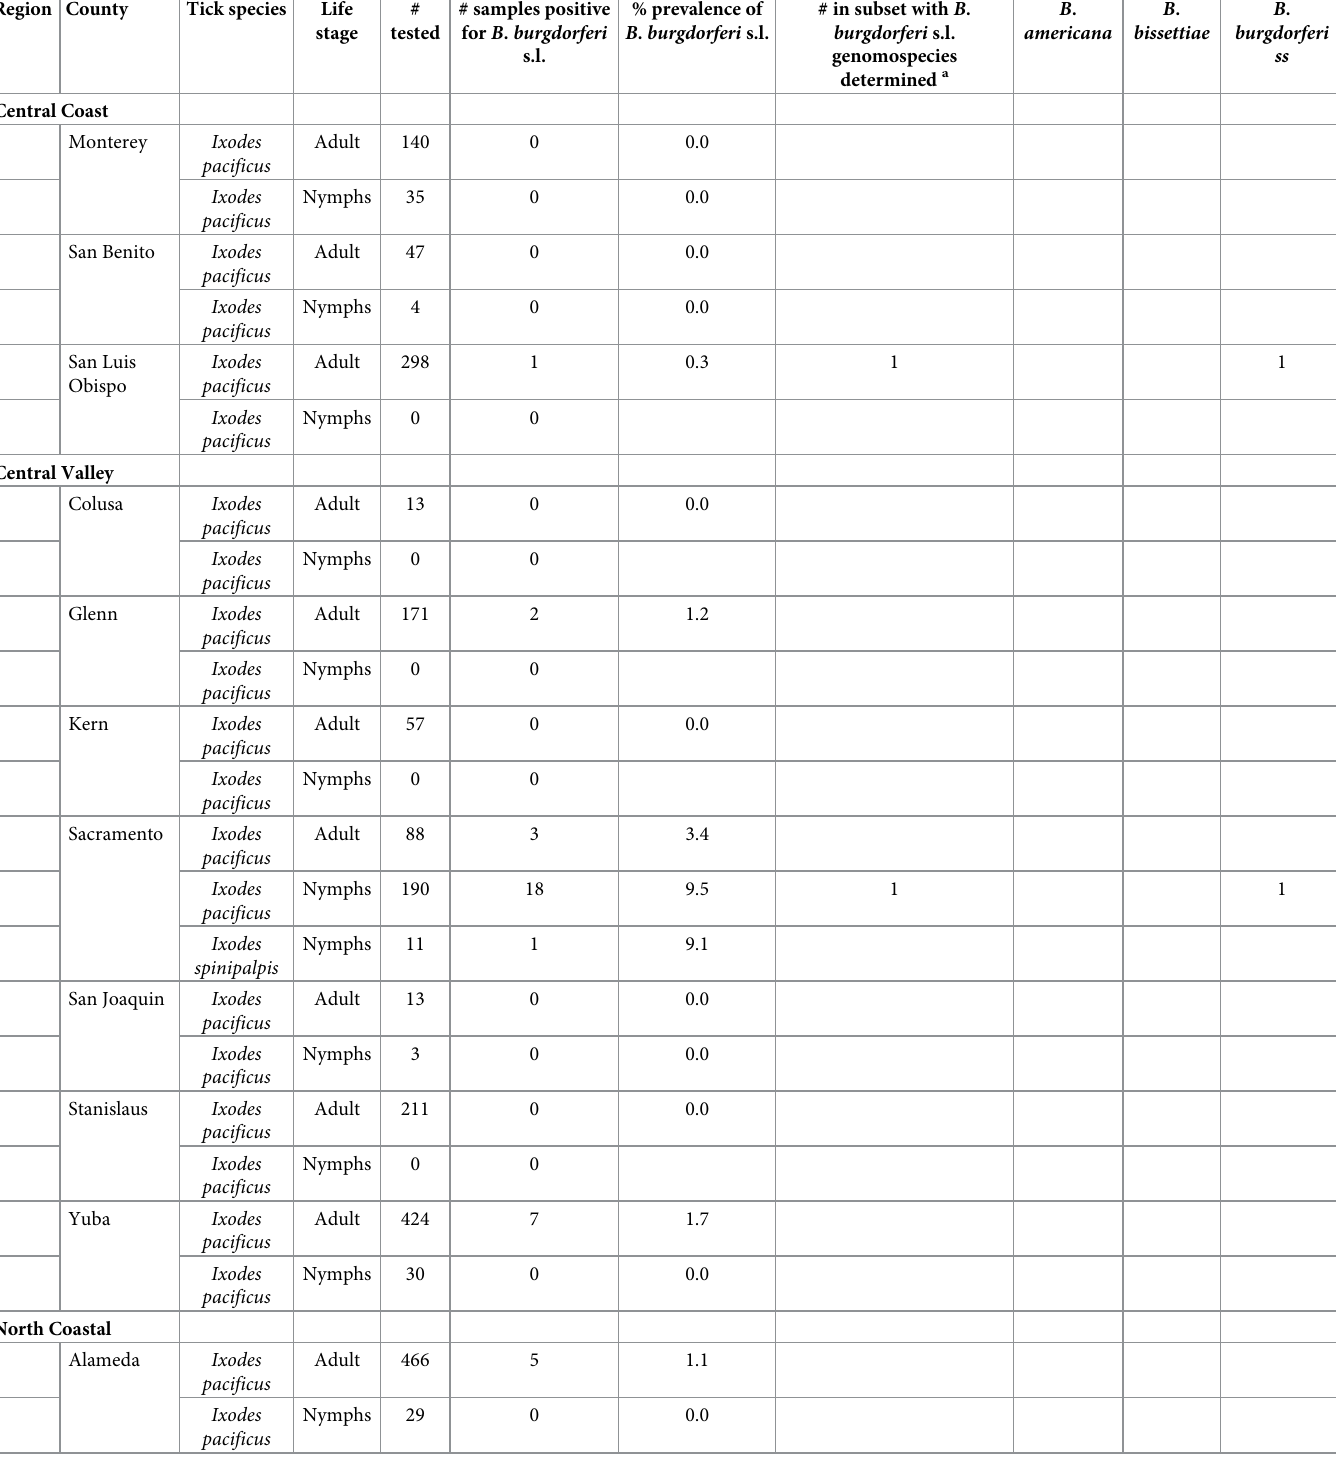
Table 1. Adult and nymphal Ixodes pacificus and Ixodes spinipalpis collected in California and tested for Borrelia spp., 2008–2015. Region